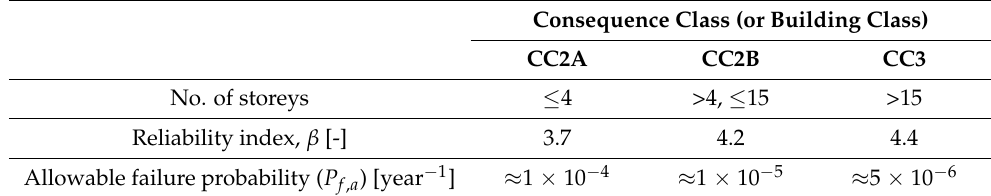
Table 9. Consequence Class, building height (no. of storeys) and allowable failure probability considering residential, retail and office type buildings